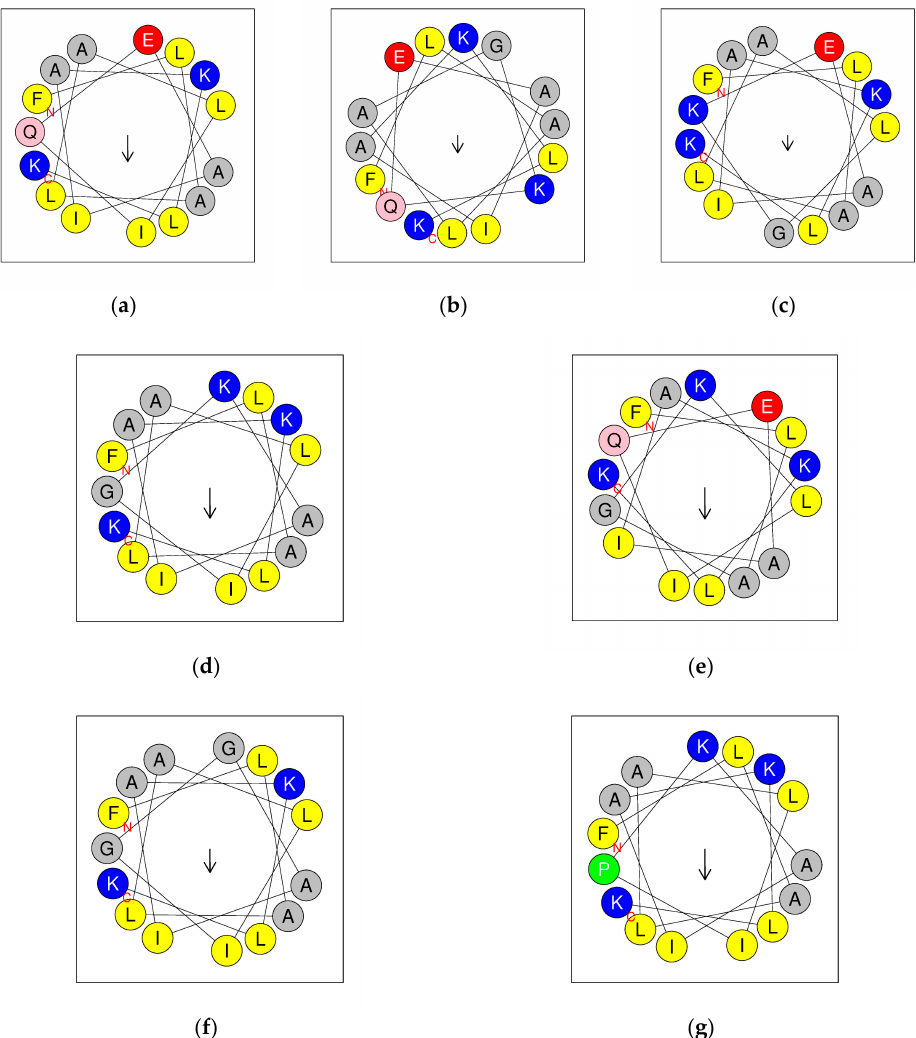
Figure 6. Helical wheel diagrams of kassporin-KS1 (QUB-1641) and synthetic analogues: QUB-1641 ( a ), QUB-1599 ( b ), QUB-1585 ( c ), QUB-1570 ( d ), QUB-1643 ( e ), QUB-1498 ( f ), and QUB-1609 ( g ). Positively charged residues are marked in blue, hydrophobic residues are yellow, negatively charged residues are red, aromatic residues are green, uncharged polar residues are pink, other non-polar residues and glycine are marked in gray. The arrow represents the direction of the hydrophobic moment.